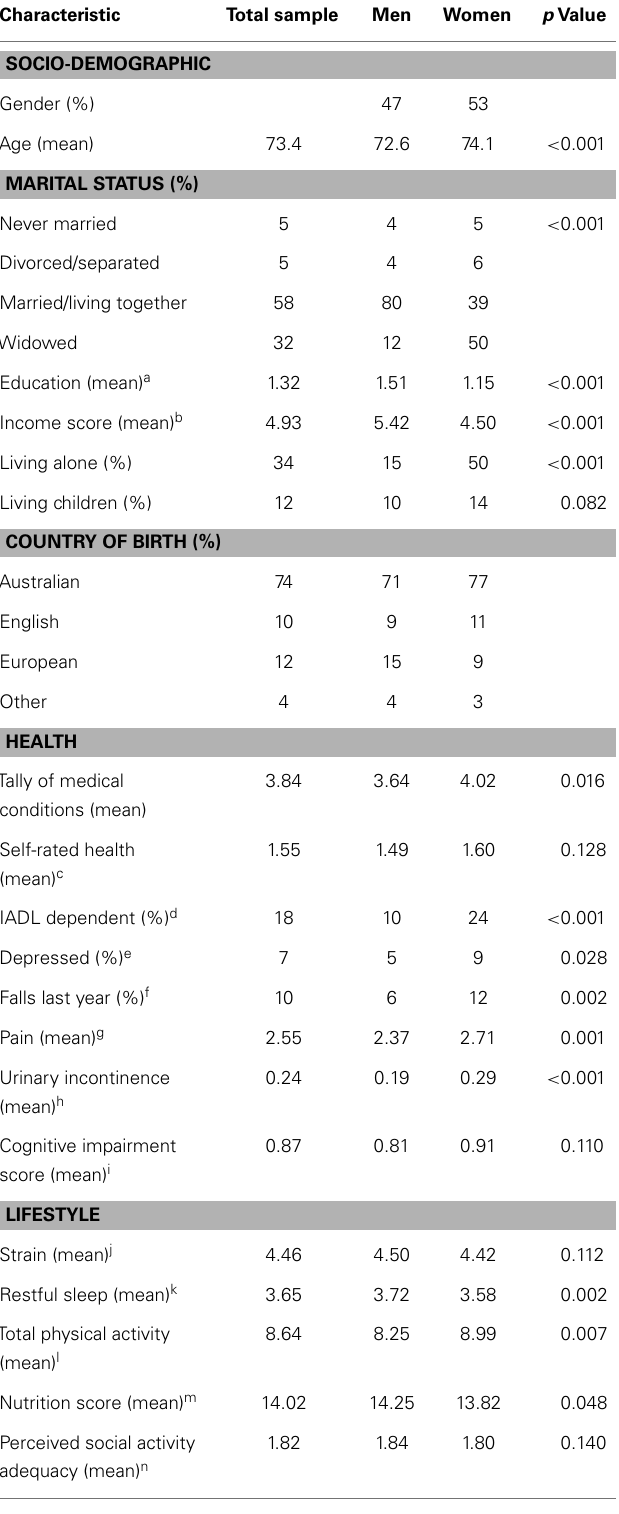
Table 1 | Baseline (1994) characteristics of participants by gender ( n = 1000)